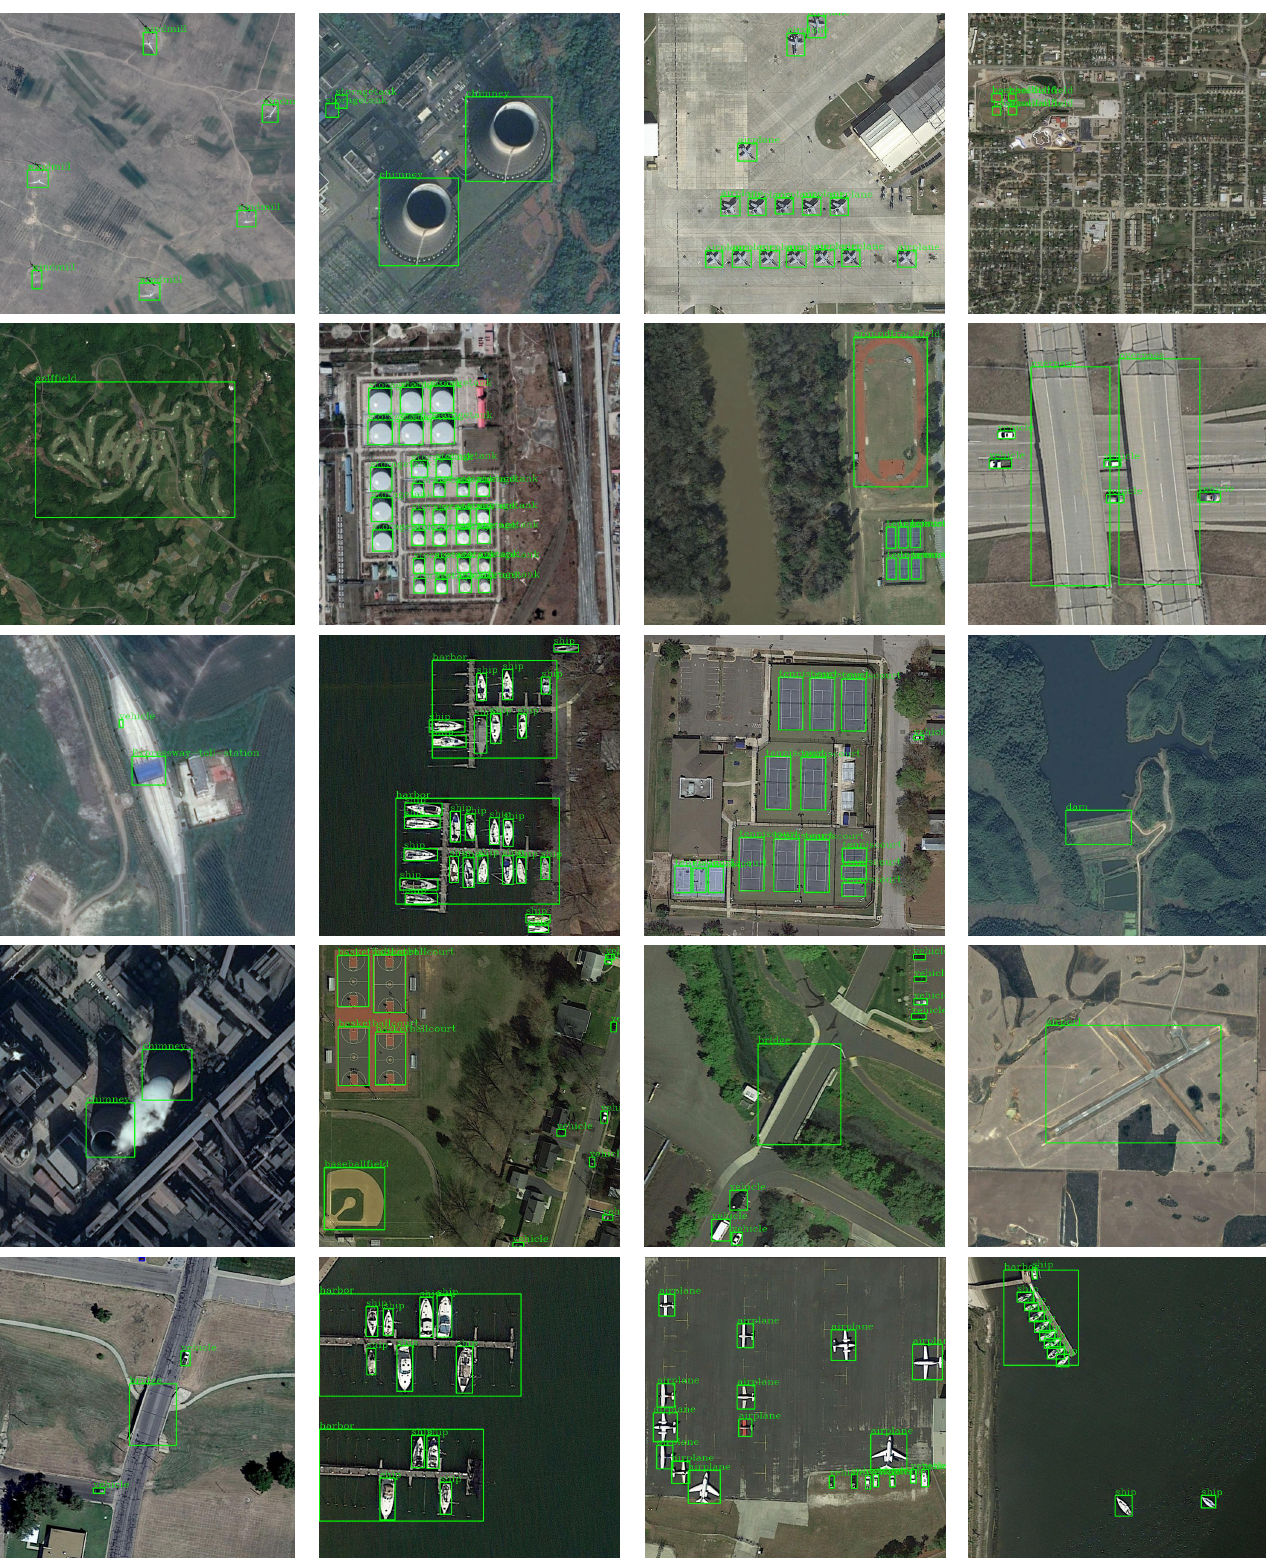
Figure 8. Some detection results of the proposed method on the DIOR dataset. The green rectangles represent